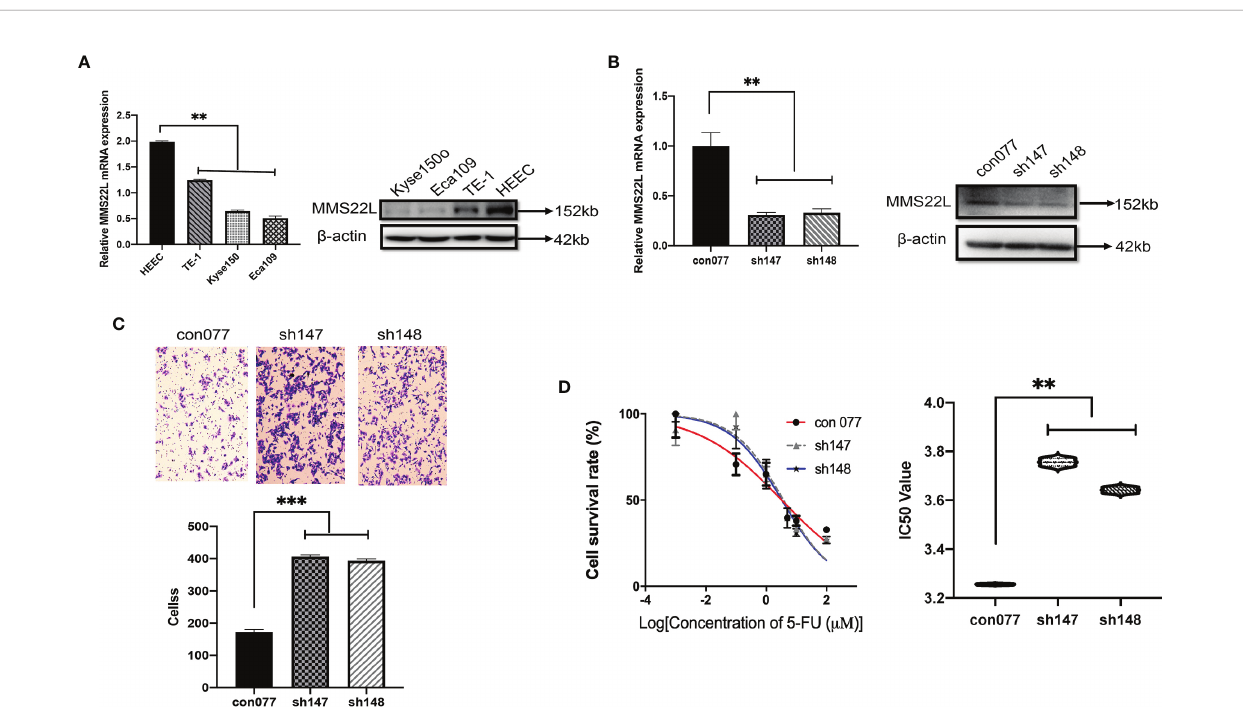
FIGURE 6 | Lower expression of MMS22L increases the migration capabilities and the 5-FU resistance of TE-1 cells. (A) MMS22L expression in a human normal oesophageal cell line (HEEC) and human ESCC cell lines. (B) The transfection ef fi ciency was measured after 48 h. (C) In the shRNA groups, the migration capabilities increased and the number of migrating cells increased compared with those in the con077 group. (D) IC 50 values of TE-1 cells to 5-FU were detected via the CCK8 assay after transfection (** p < 0.01; *** p < 0.001). CCK8, cell counting kit; IC 50 , half-maximal inhibitory concentration; 5-FU, 5- fl